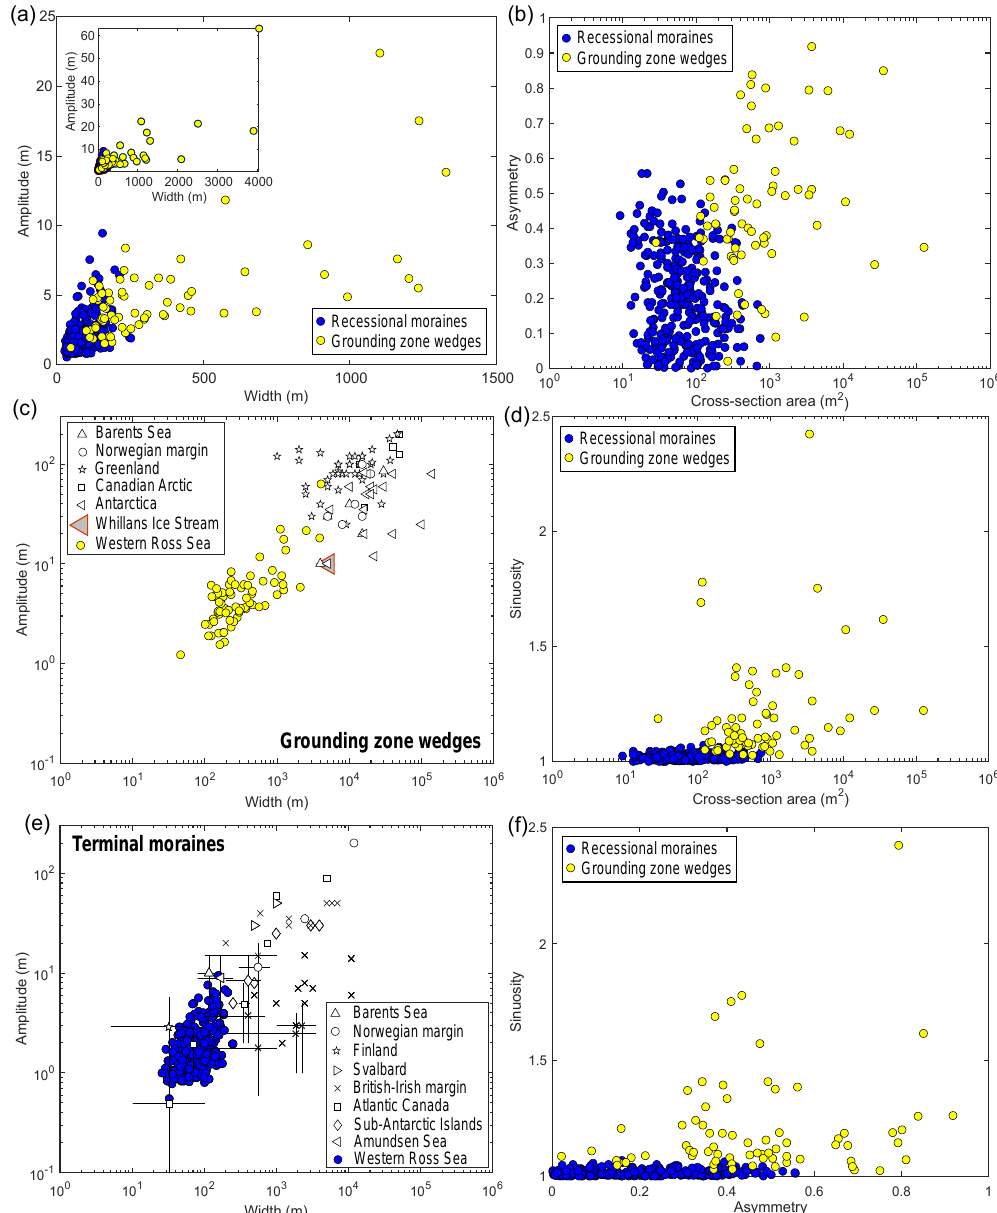
Figure 5. Paired variable plots of landform morphometry typically distinguish grounding zone wedges from recessional moraines. (a–c) A scaling relationship exists between landform width (distance in the along-flow direction) and amplitude in the western Ross Sea landform population, consistent with global examples of grounding zone wedges (b) and terminal moraines (c) . (d) Landform asymmetry and (e) sin- uosity cluster differently between landform type with respect to landform size (cross-section profile area). (f) Asymmetry against sinuosity shows clustering of low-sinuosity, relatively symmetric recessional moraines. Literature sources for data in (b) and (c) are listed in the